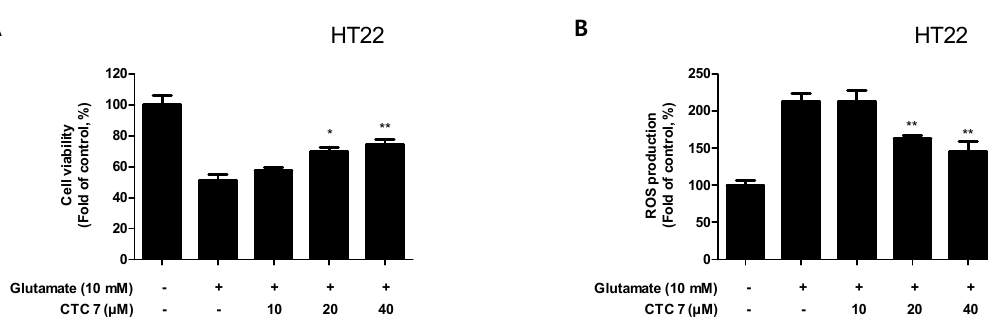
Figure 6. Effects of CTC 7 treatment on glutamate-induced ( A ) oxidative neurotoxicity and ( B ) ROS generation in HT22 cells. HT22 cells were pretreated with CTC 7 (10, 20, and 40 μ M) for 3 h and then incubated with glutamate (10 mM) for 12 h. Data are presented as the mean ± standard deviation for three independent experiments. * p < 0.05, ** p < 0.01 when compared to glutamate-treated cells.